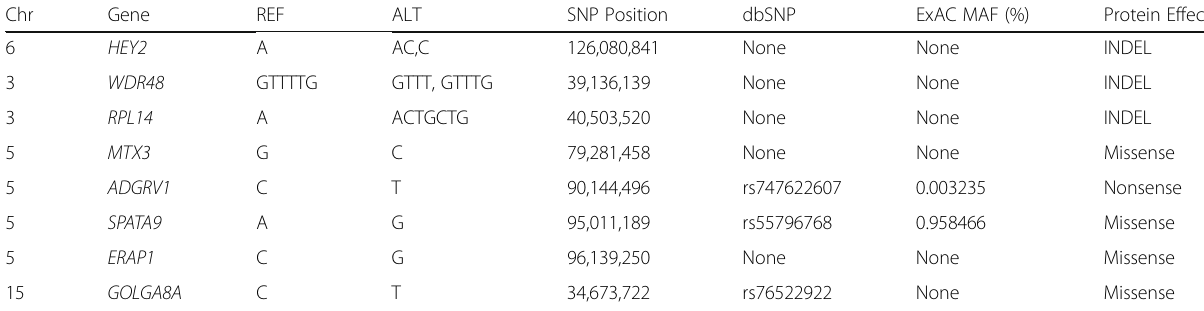
Table 2 Eight variants identified by whole exome sequencing